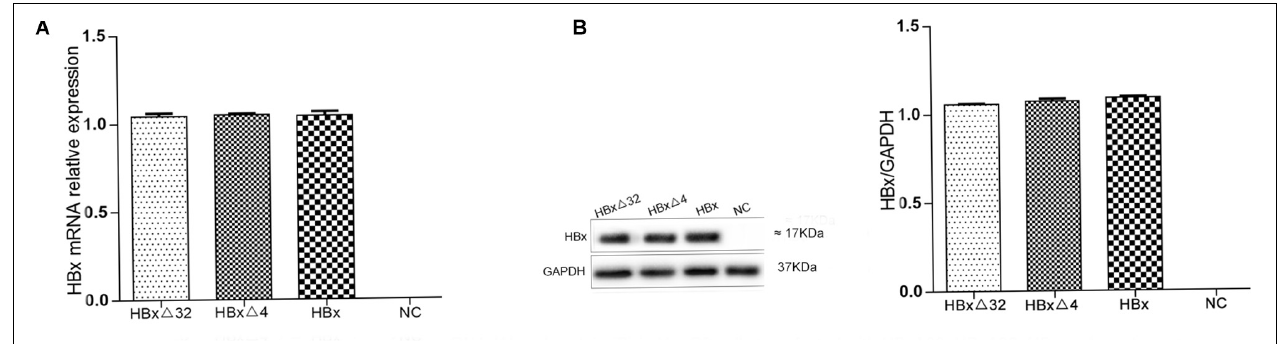
FIGURE 1 | Expression of HBx mRNA (A) and protein (B) in HepG2 cells transfected with HBx (cid:49) 32, HBx (cid:49) 32, HBx and empty vector. HBx (cid:49) 32, HBx (cid:49) 4, HBx and empty vector [negative control (NC)] were transfected to HepG2 cells respectively. The mRNA and protein expression levels of HBx and the two mutants were assessed by qRT-PCR (A) and Western blot (B) . Except for NC group, the HBx (cid:49) 32, HBx (cid:49) 4, and HBx groups were demonstrated that the transfected genes and proteins were efficiently expressed and shown no significant difference. As the picture (B) showed, the molecular weights of HBx (cid:49) 32, HBx (cid:49) 4, and HBx are equal to or very closed to 17 kDa. The gel used for Western Blot are precast and applicable for proteins with molecular weights from 10 to 180 kDa, equivalent to the gel concentrations range from 4 to 20%.